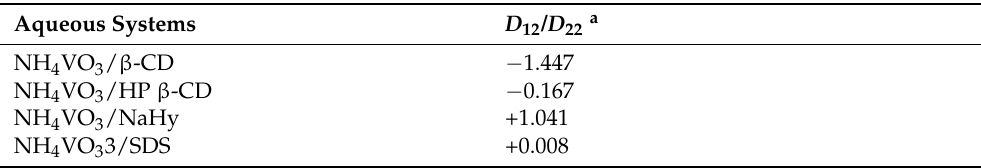
Table 4. Moles transporting NH 4 VO 3 ( C 1 = 0.001 mol dm − 3 ) by different potential carriers ( β -CD, HP- β -CD, NaHy, and